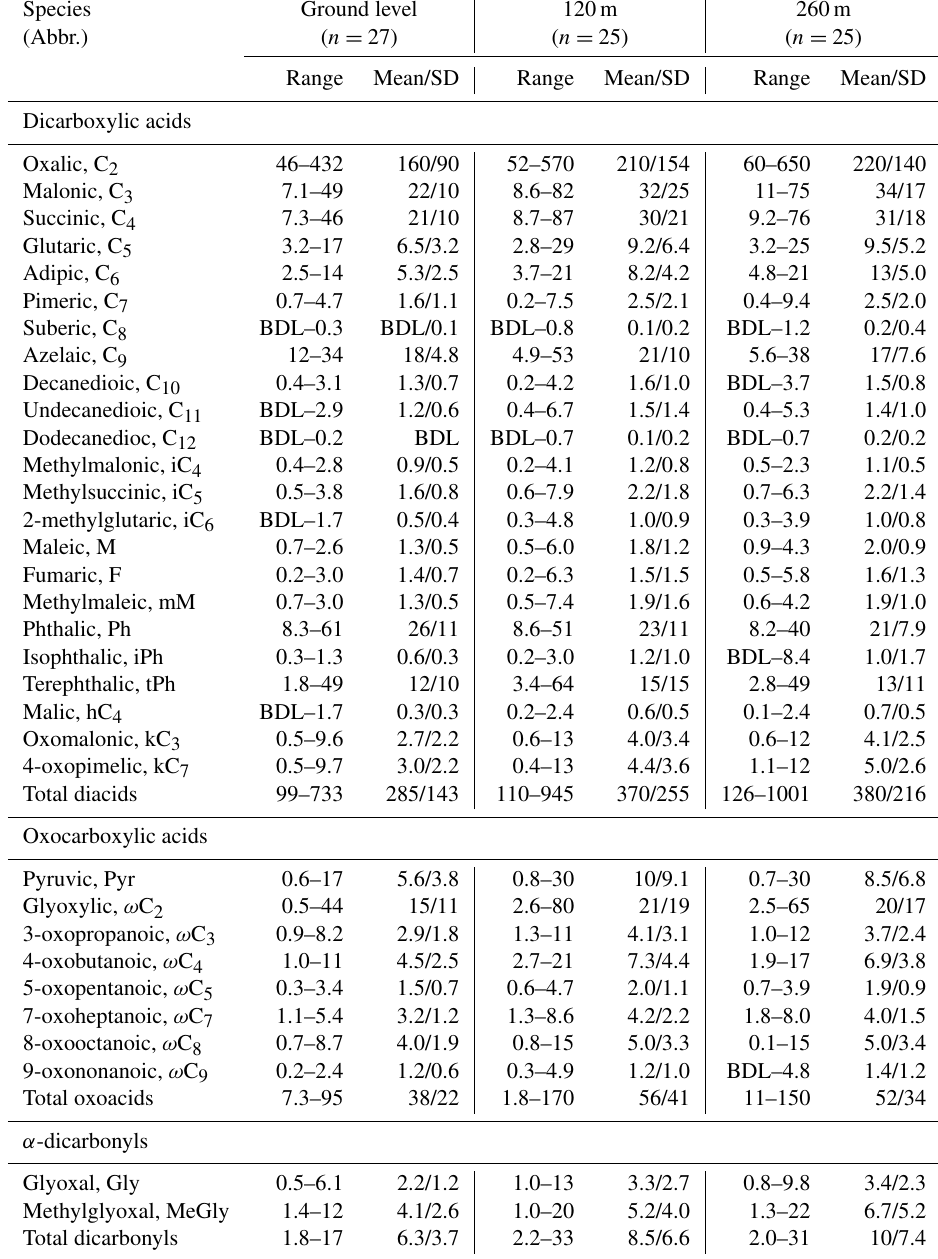
Table 2. Vertical concentrations (ngm − 3 ) of dicarboxylic acids, oxoacids and α -dicarbonyls collected in Beijing from 15 August to 10 September